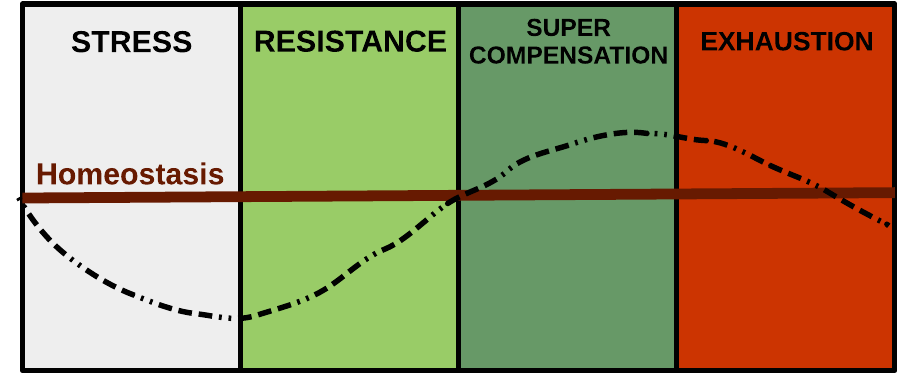
Figure 3. General Adaptation Syndrome. Challenging tasks produce stress, test available abilities and yield failures. Present abilities are improved as resistance, then new ones are developed as super-compensation. Relaxing helps fixing acquired abilities, as continued stress ends up in